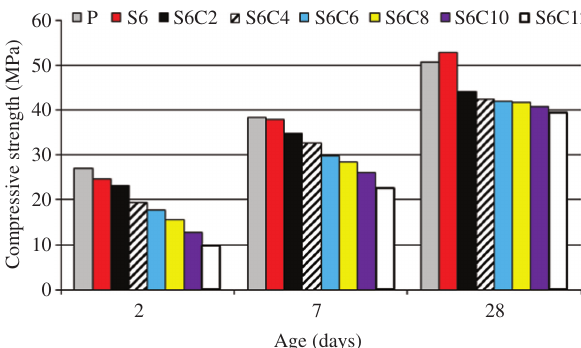
Figure 8 Compressive strengths of mixtures.